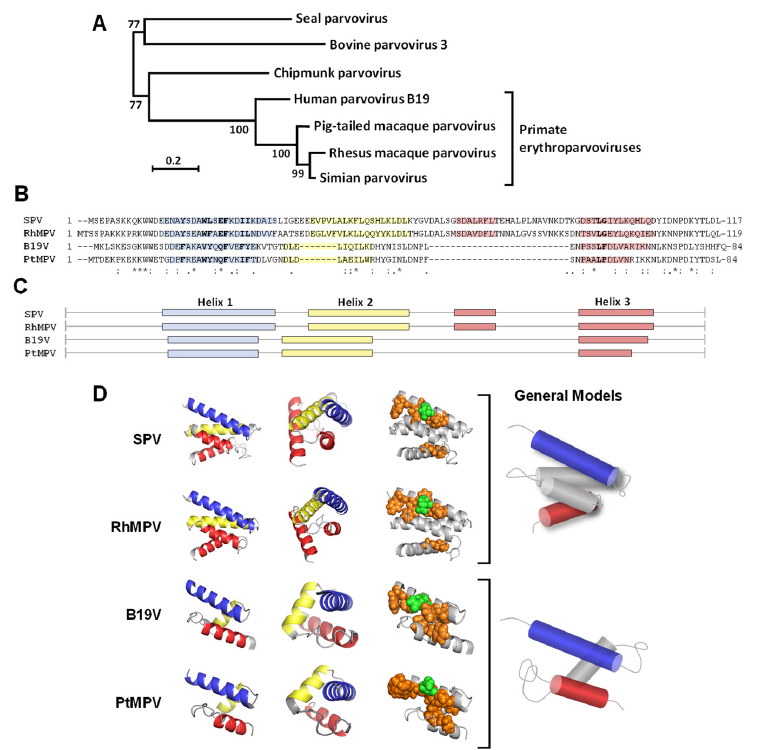
Figure 5. N-VP1u from primate erythroparvoviruses. ( A ) Phylogenetic tree of the genus Erythroparvovirus. VP1 sequences were aligned with MUSCLE configured for the highest accuracy [42], and the tree was reconstructed using the maximum-likelihood method implemented in the PhyML program [43]. Bootstrap values are indicated. ( B ) N-VP1u sequences were aligned using the Clustal Omega multiple sequence alignment program. Relevant amino acids for VP1u internalization are highlighted in bold letters. ( C ) Helix distribution according to secondary structure prediction in QUARK modeling. Helix 1 is blue, helix 2 is yellow, and helix 3 is red. ( D ) The RBDs (SPV AA 14-117, RhMPV AA 15-119, B19V 14-84, and PtMPV AA 14-84) were modeled by QUARK and visualized with PyMOL, showing similar high-confidence structure predictions of the different viruses. First column: front view with the N-terminus top left and the C-terminus in the lower part; second column: side view of the models; third column: spatial cluster of the important amino acids as spheres in the helical structure (green: polar; orange: hydrophobic). A schematic representation of the two models of helix configuration is shown on the right. SPV: simian parvovirus; RhMPV; rhesus macaque parvovirus; B19V: parvovirus B19; PtMPV: pig-tailed macaque parvovirus. Secondary and tertiary protein structure predictions of N-VP1u were performed with distribution and the tertiary structure of N-VP1u of primate erythroparvoviruses show striking similarities (Figure 5C). The RBDs of human B19V and PtMPV is composed of three helices. Both RBDs show an identical helix distribution, leading to a very similar 3D